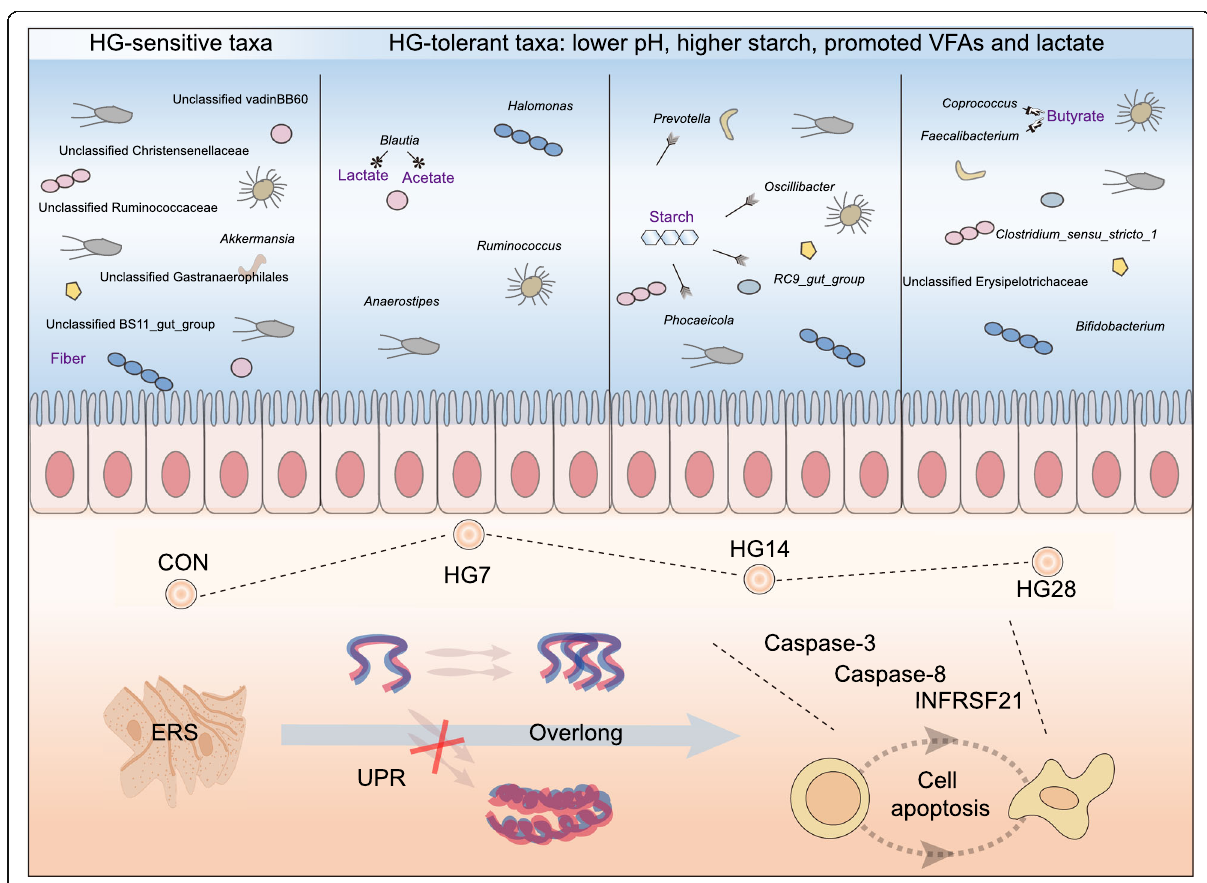
Fig. 5 A holistic view of microbiome – host co-oscillation patterns in remodeling of colonic homeostasis during adaptation to an HG diet in a sheep